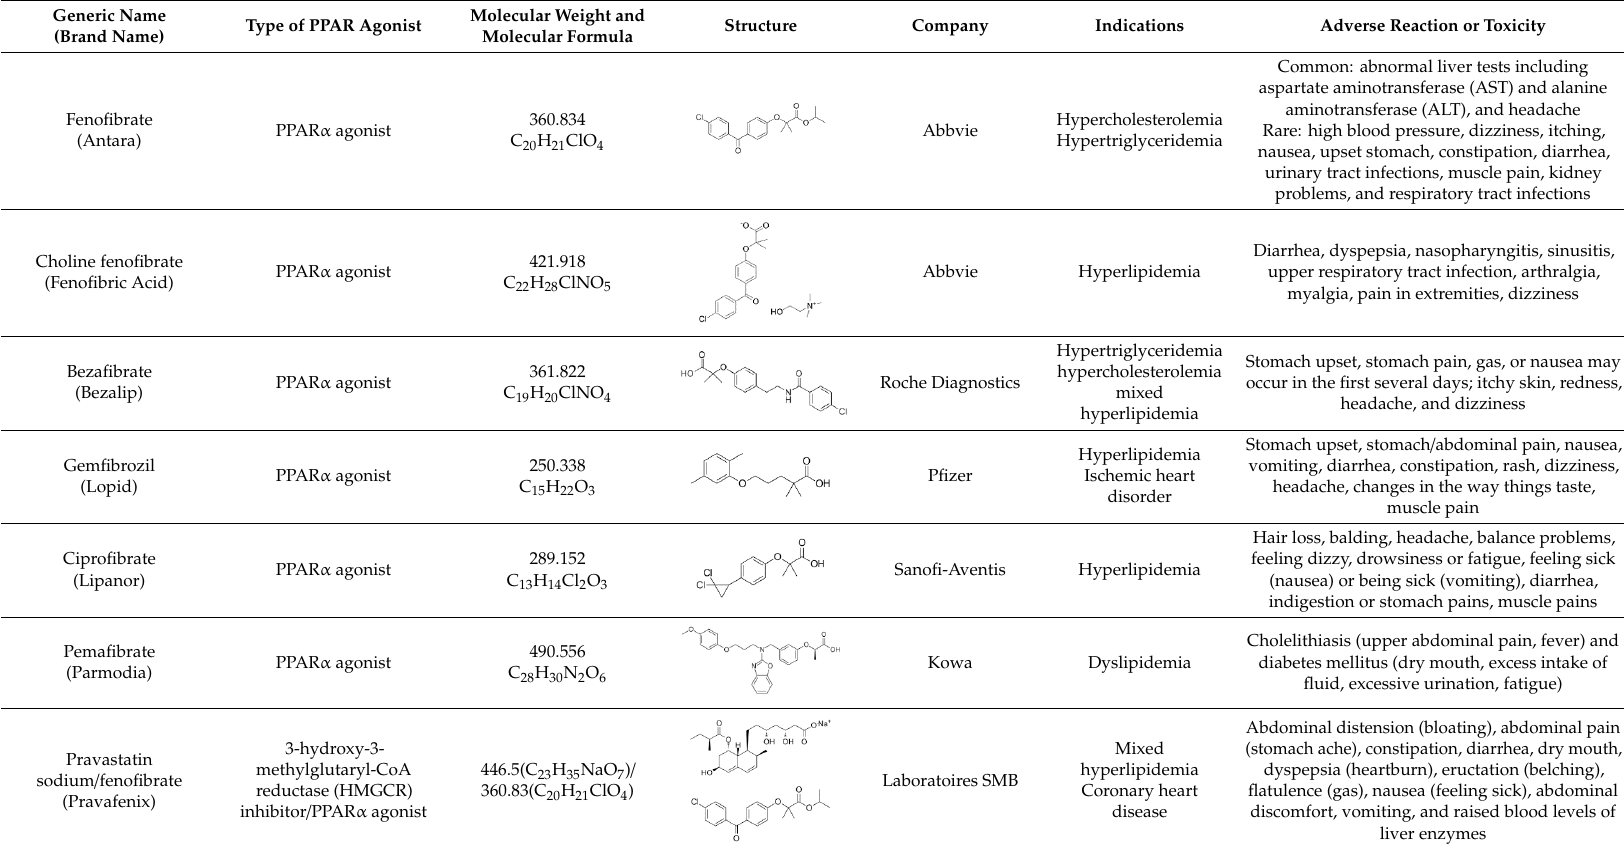
Raised blood creatinine levels, upper-respiratory- tract infection (colds), increased blood platelet counts, gastroenteritis (diarrhea and vomiting) and increased levels of alanine aminotransferase